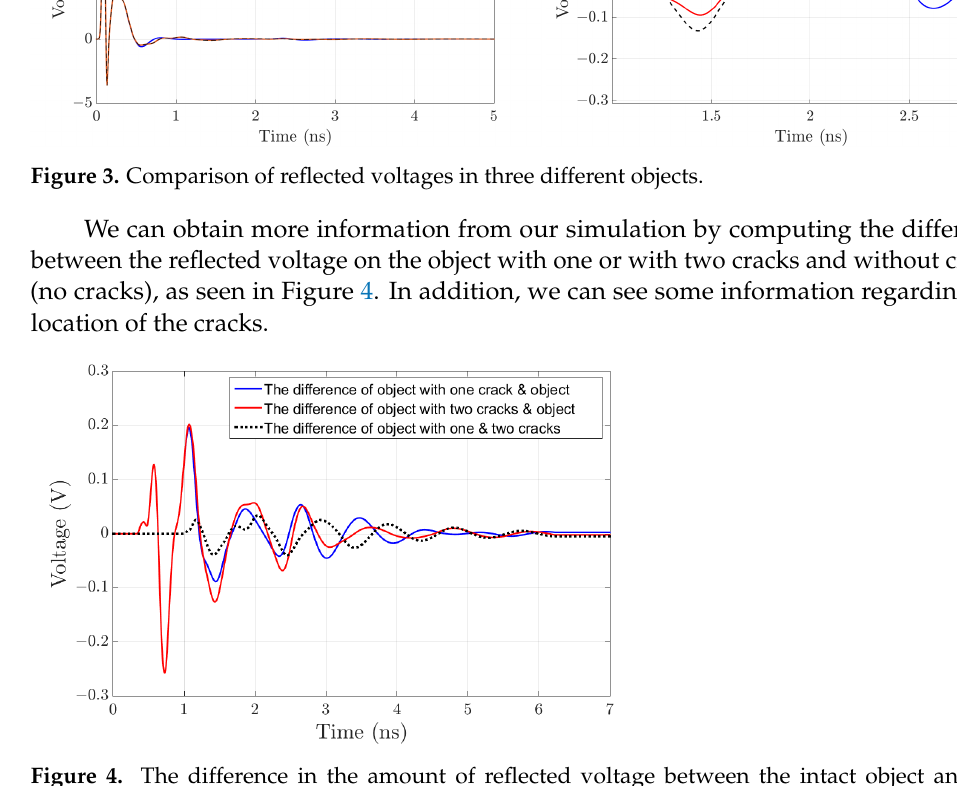
Figure 4. The difference in the amount of reflected voltage between the intact object and the cracked object.